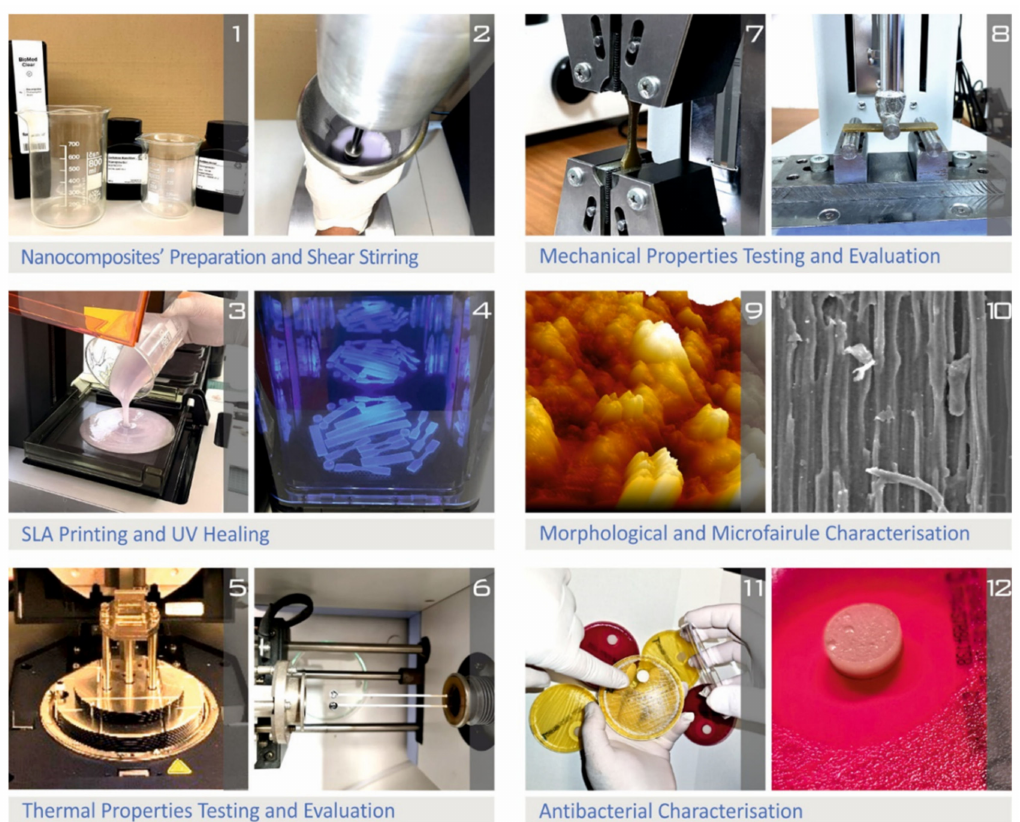
Figure 1. Flow chart illustrating the methodology followed to fabricate the different nanocomposites, as well as representative characterization techniques: ( 1 ) The additives used in this work, ( 2 ) materials mixing, ( 3 ) materials feeding in the 3D printer, ( 4 ) 3D printing process, ( 5 ) Mechanical testing (DMA), ( 6 ) Thermal properties (TGA), ( 7 ) Mechanical testing (tensile test), ( 8 ) Mechanical testing (flexural test), ( 9 ) morphological analysis (AFM), ( 10 ) morphological analysis (SEM), ( 11 ) (well agar diffusion), ( 12 ) antibacterial tests (inhibition